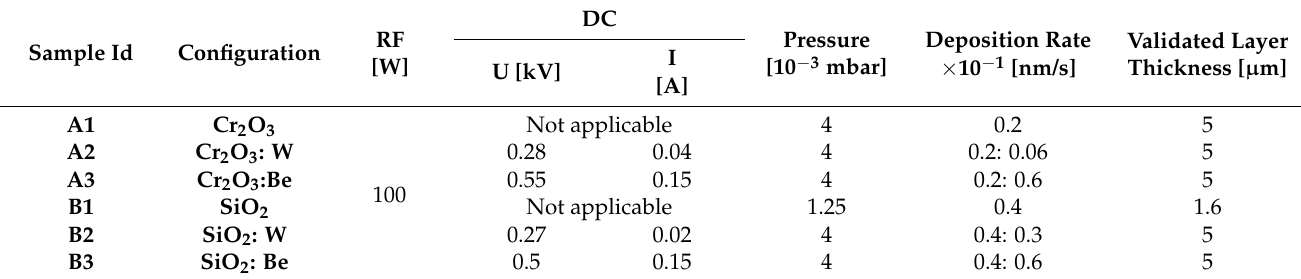
Table 1. Deposition